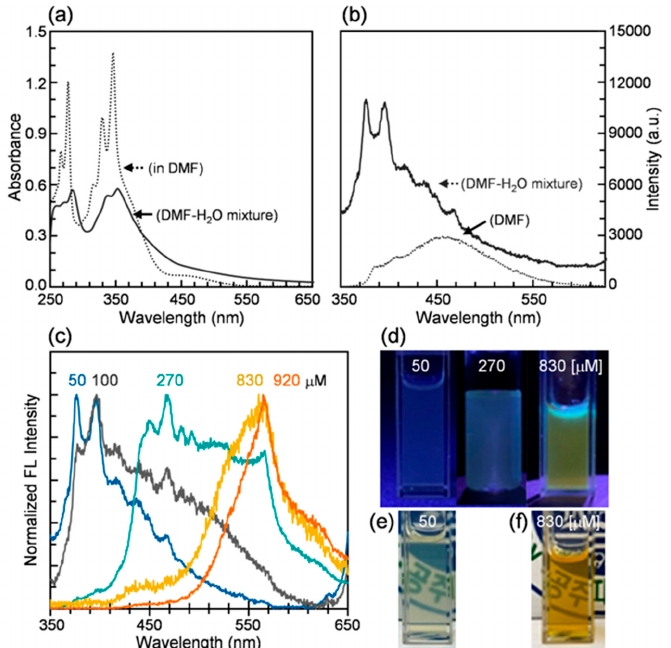
Figure 5. Concentration dependence of emission wavelength: Changes in ( a ) UV-vis absorption spectra before (20 µ M in DMF) and after the formation of sheet-like structures (20 µ M in DMF-H 2 O). ( b ) Fluorescence spectra in DMF solution (50 µ M) and in DMF–H 2 O mixture (50 µ M, 1/1, v / v ). ( c ) Normalized fluorescence spectra of turbid suspensions at different concentrations. ( d ) Emission under UV light irradiation. ( e , f ) Photographs of turbid DMF ‐ H 2 O mixtures.